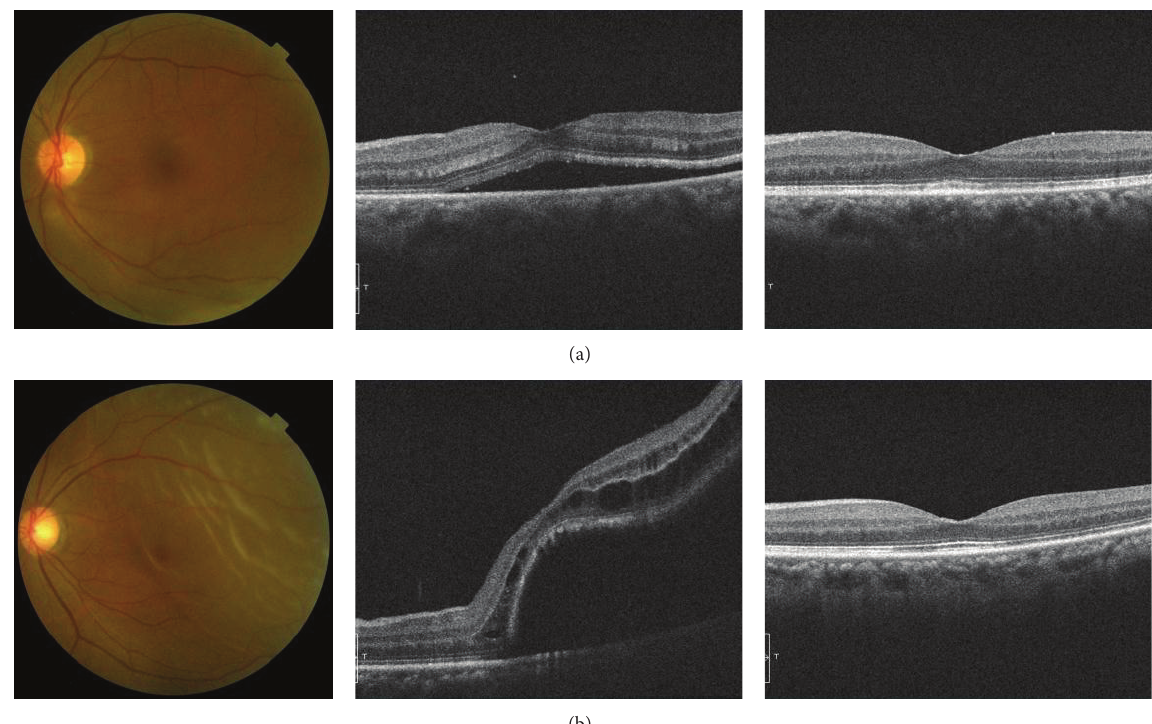
Figure 3: Representative eyes with good and poor visual outcomes after surgery for macula-off rhegmatogenous retinal detachment. (a) 65-year-old woman (preoperative decimal visual acuity: 0.7) with a good visual outcome (postoperative decimal visual acuity: 1.2). (b) 60- year-old woman (preoperative decimal visual acuity: 0.3) with a poor visual outcome (postoperative decimal visual acuity: 0.3). Preoperative photographs of the fundus, preoperative optical coherence tomography (OCT) images, and postoperative OCT images are shown on the left, center, and right, respectively. Preoperative foveal area was relatively thinner in the case with a poor outcome than in the case with a good